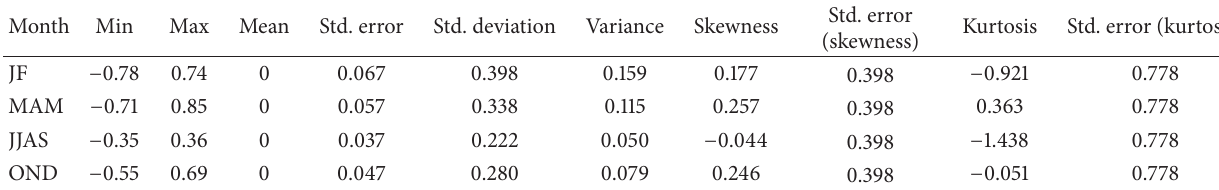
Table 7: General statistics of temperature at 500hPa.